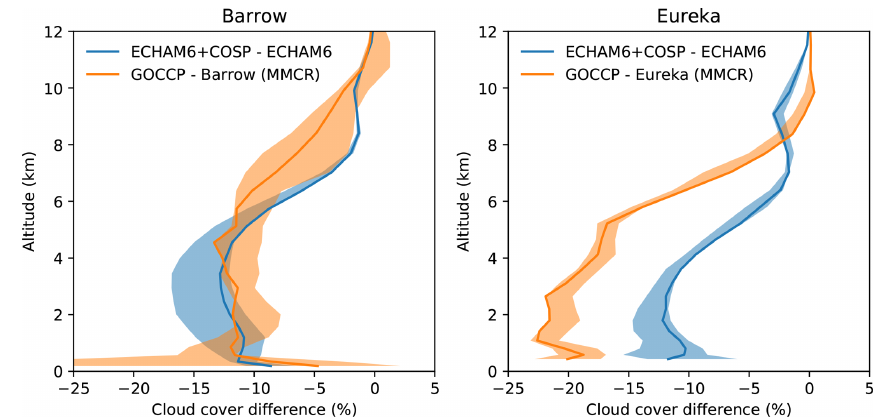
Figure 1. Difference in cloud cover profiles (from 2007 to 2009) of ECHAM6 + COSP minus ECHAM6 and GOCCP minus ground-based observations. Cloud cover profiles from ground-based observations are derived from 35GHz millimeter cloud radars (MMCRs) in Barrow and Eureka as described in Shupe et al. (2011). Shaded areas show the effect of using the neighboring grid points around the location in the grided data.